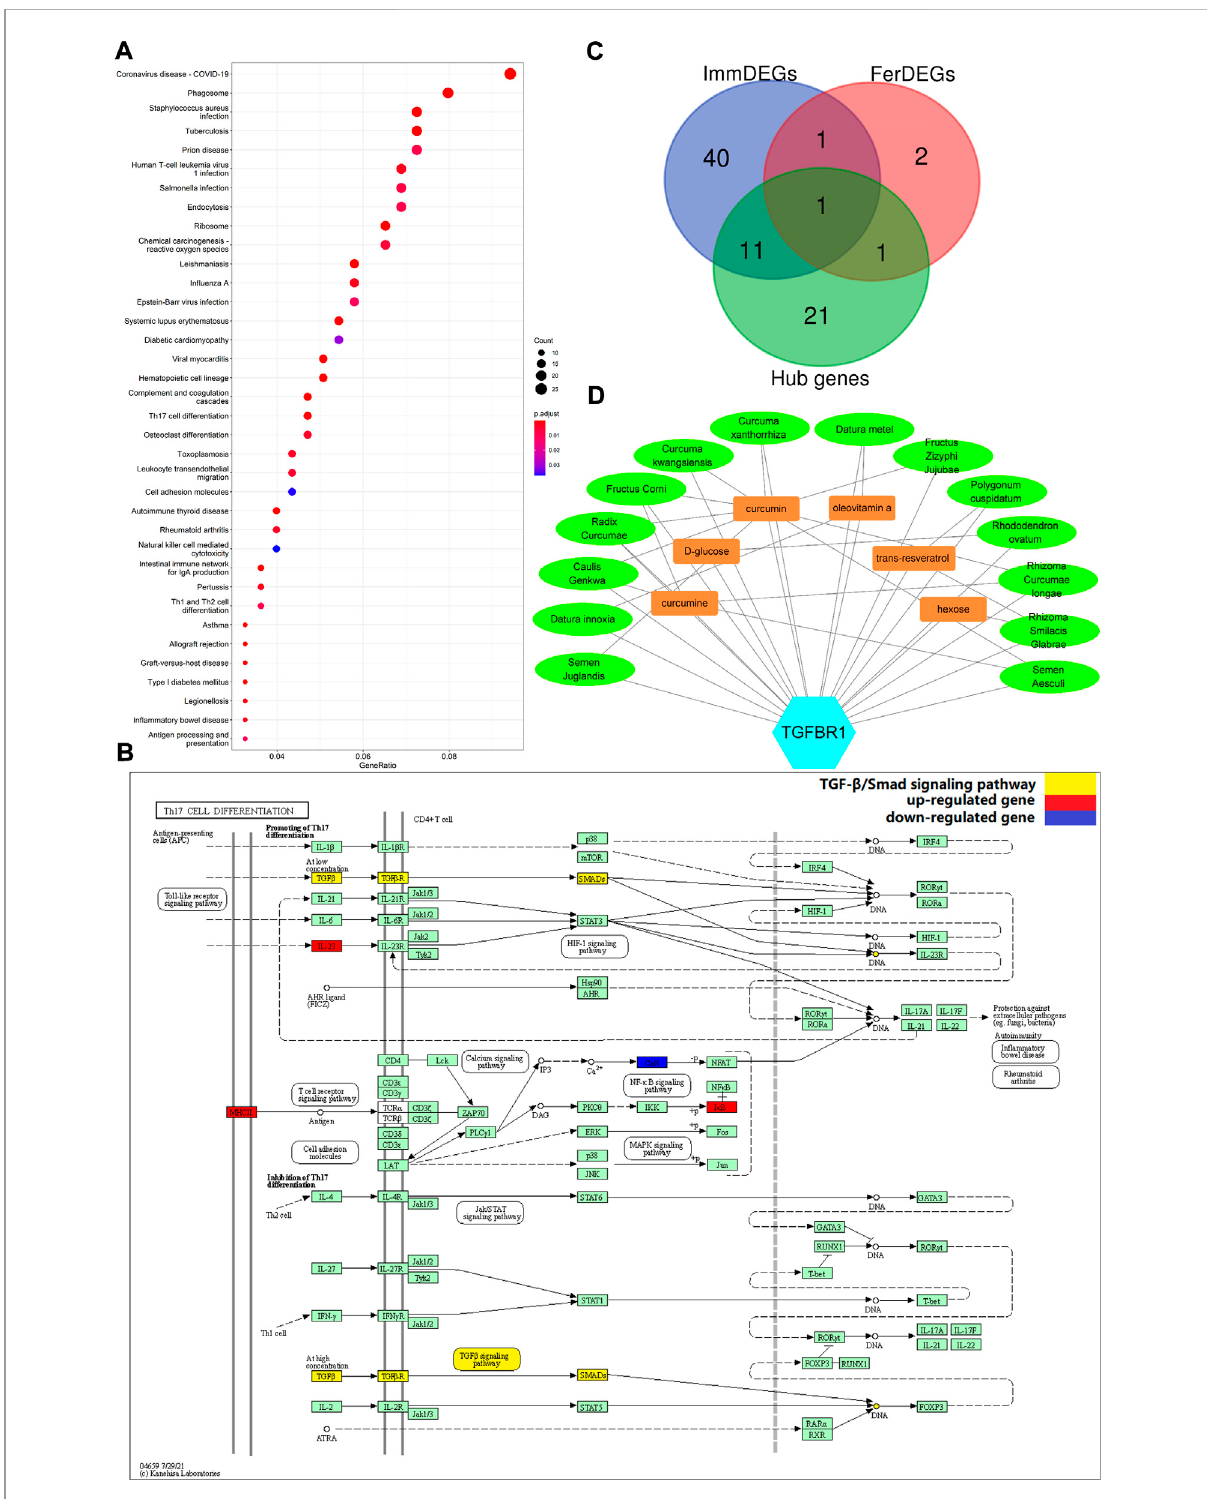
FIGURE 3 (A) Enriched KEGG pathways (n = 36) are shown. The horizontal axis represents the ratio of the number of DEGs enriched in a pathway to the total number of genes in the pathway. Dot size is proportional to the gene-ration, and dot color from blue to red implies that the adjusted p value is smaller. (B) Th17 cell differentiation pathway. Red nodes represent upregulated DEGs, blue nodes represent downregulated DEGs; the pathway marked in yellow is the TGF β /Smad signaling pathway. (C) TGFBR1 at the intersection of ImmDEGs, FerDEGs, and hub genes. TGFBR1